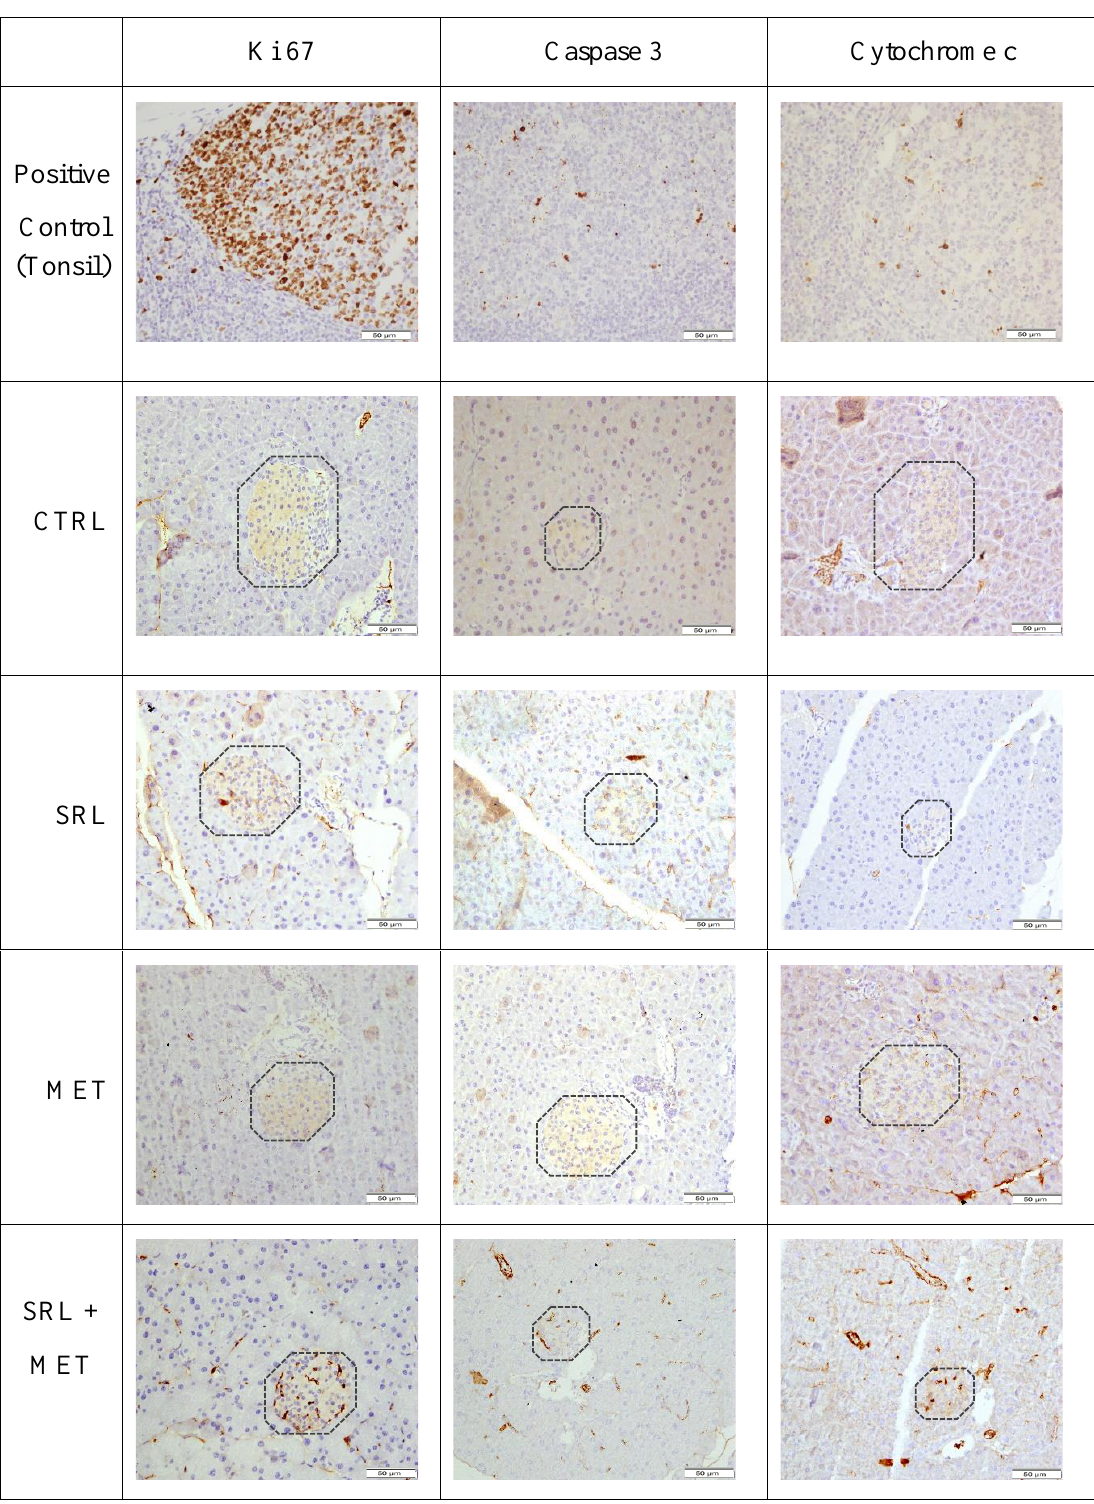
Figure 8. Immunohistochemical staining for Ki 67, caspase-3, and cytochrome C in pancreas sections of mice treated with water (CTRL), 5 µ g/g of SRL alone, 200 µ g/g of MET alone and SRL+MET cotreatment for 4 weeks. Magnification